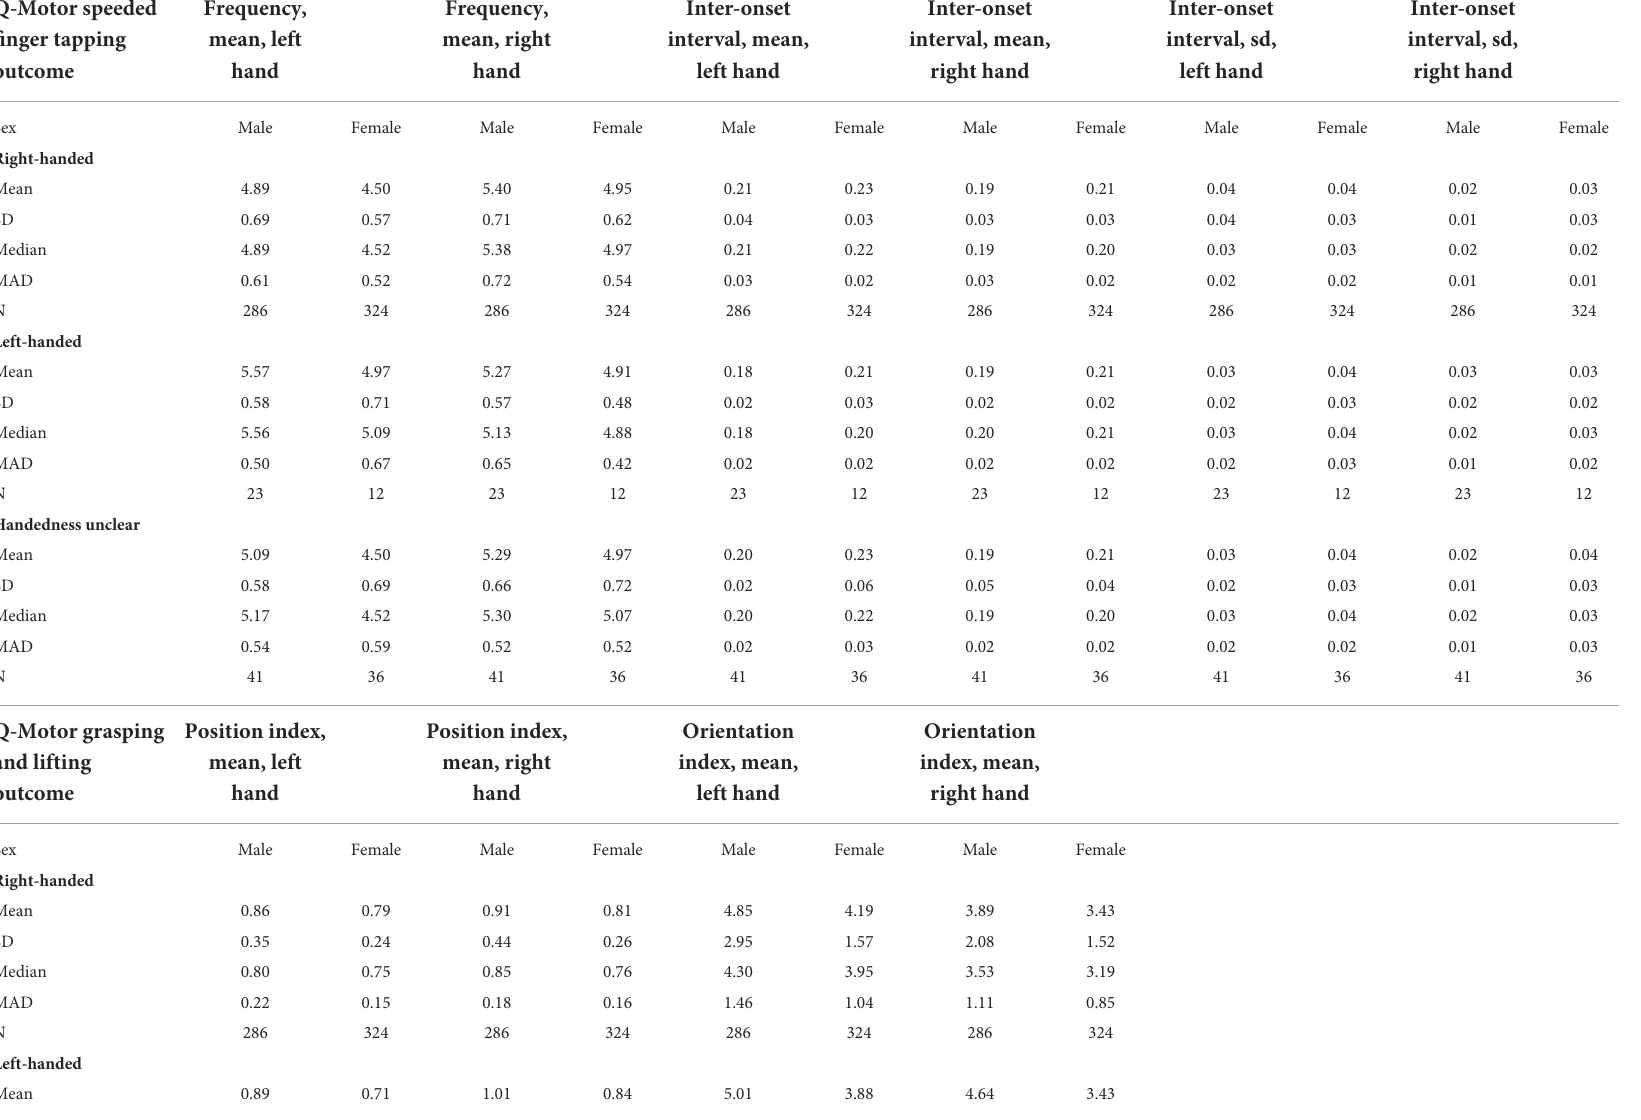
TABLE 4 Measures of central tendency and variability for the (non-transformed) motor outcomes in left and right hands, stratified by test, sex, and handedness. Q-Motor speeded finger tapping